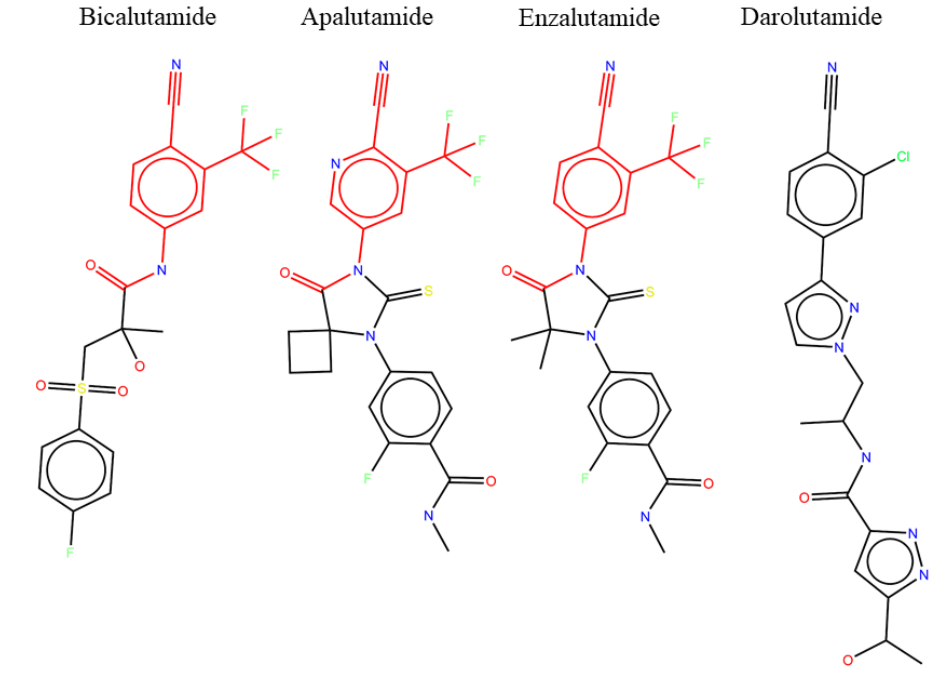
Figure 7. Chemical structures of anti-androgens with common substructure